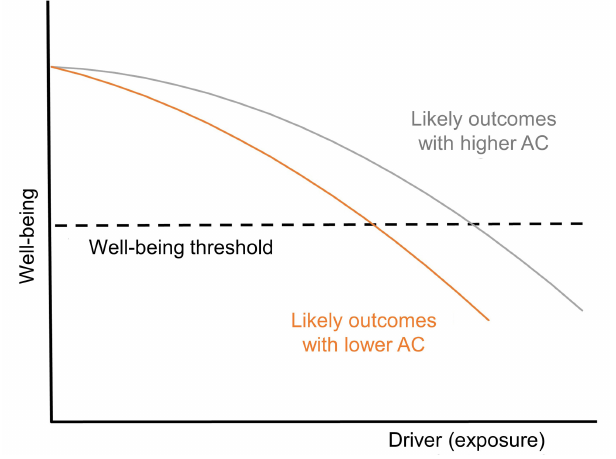
Fig. 1 . Vulnerability (likely outcomes falling below a threshold) depends on driver level or rate (exposure), initial well-being, sensitivity (incremental change in likely outcomes, slope of curve), and adaptive capacity (AC). AC increases the range of driver states with likely outcomes above the threshold.